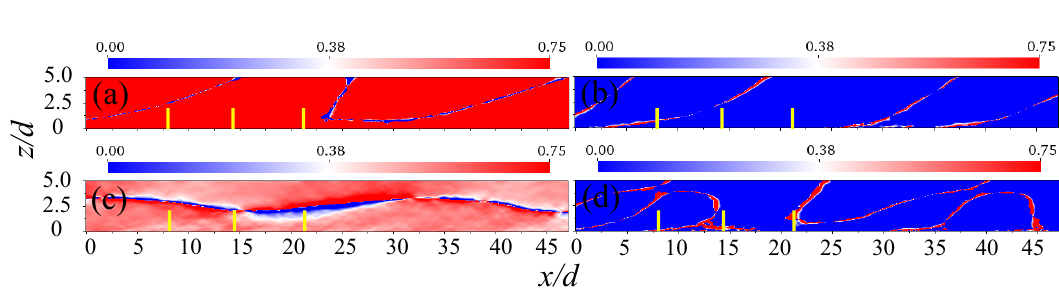
Figure 17. Phase of streamwise Fourier-POD mode for wave-number k y d = 0.4. ( a ) m = 1, ( b ) m = 2, ( c ) m = 3, ( d ) m = 4. Red-blue contours indicate the phase of the streamwise modes, ( ϕ u ) ( ϕ u )) . Thick yellow vertical lines–turbine ψ = tan ( k k I R